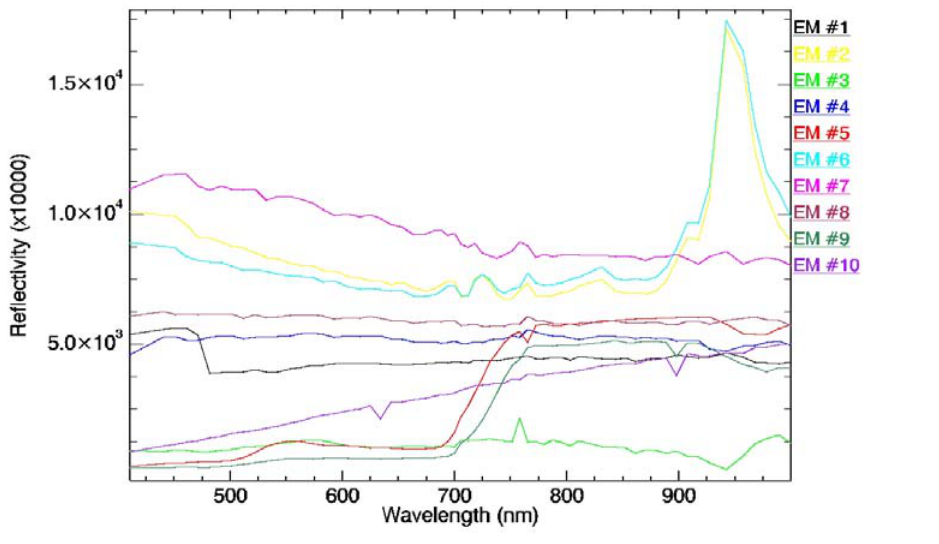
Figure 14. Reflectivity spectra for the endmembers extracted automatically from the image using the